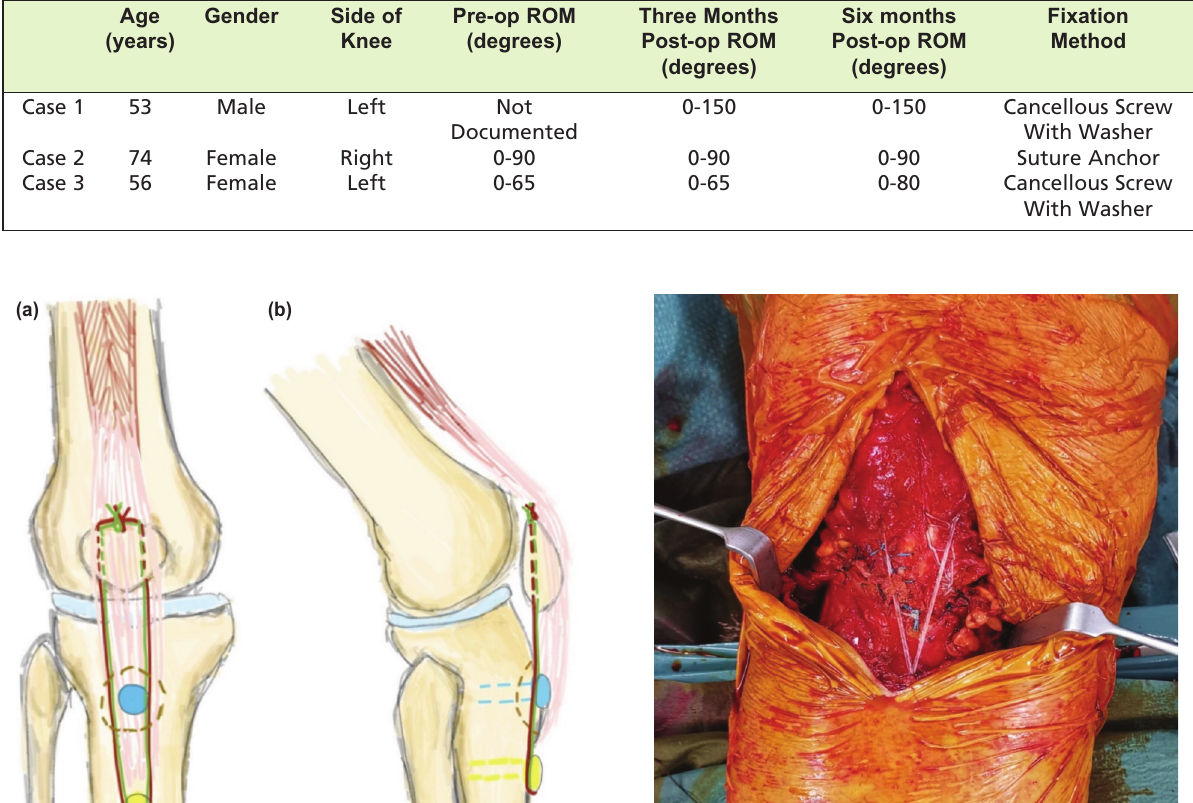
A summary of our Table I: